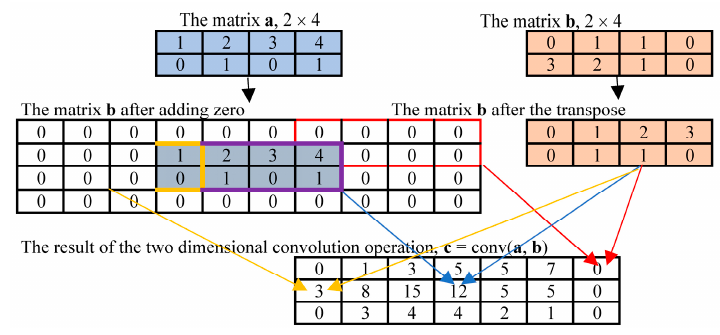
Figure 3. Quadratic convolution neural network structure model.